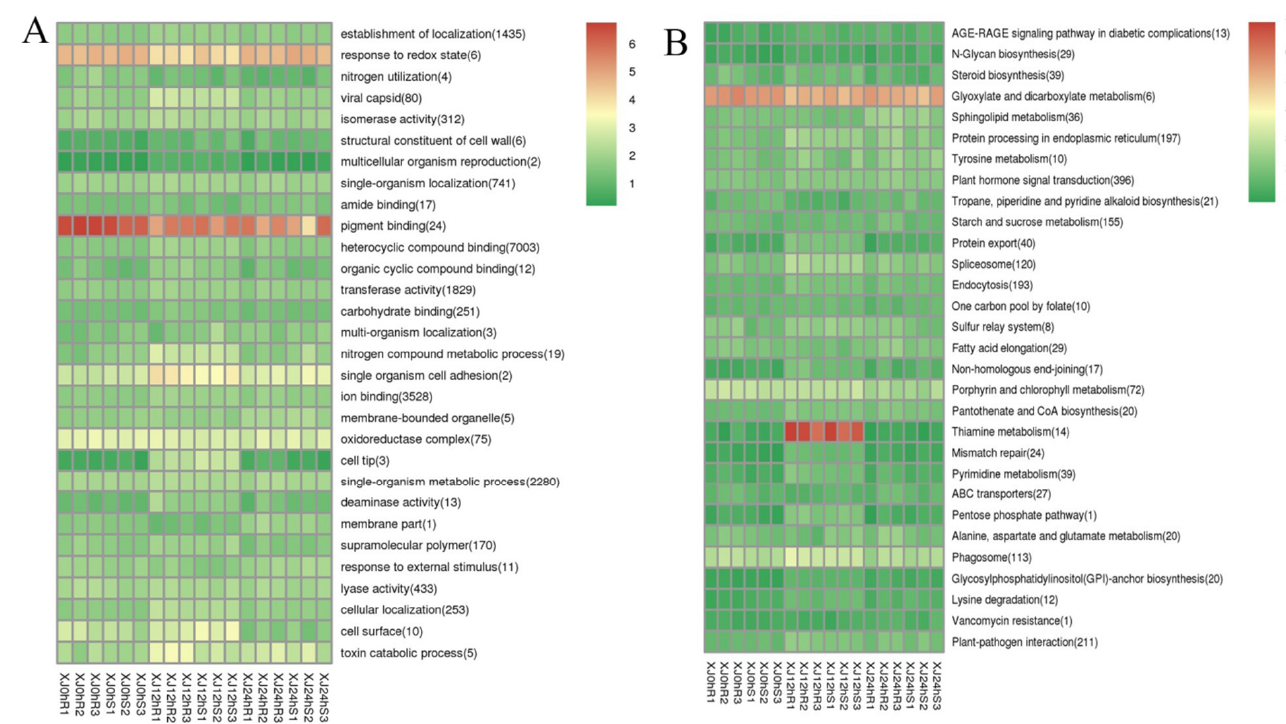
Figure 7. ( A ): GO enrichment cluster map for differentially expressed genes; ( B ): KEGG enrichment cluster map for differentially expressed genes. Note: Red indicates metabolic pathways with high expression, and blue indicates metabolic pathways with relatively low expression. The parentheses after the label for each metabolic pathway include the number of genes in the metabolic pathway with significant differences.